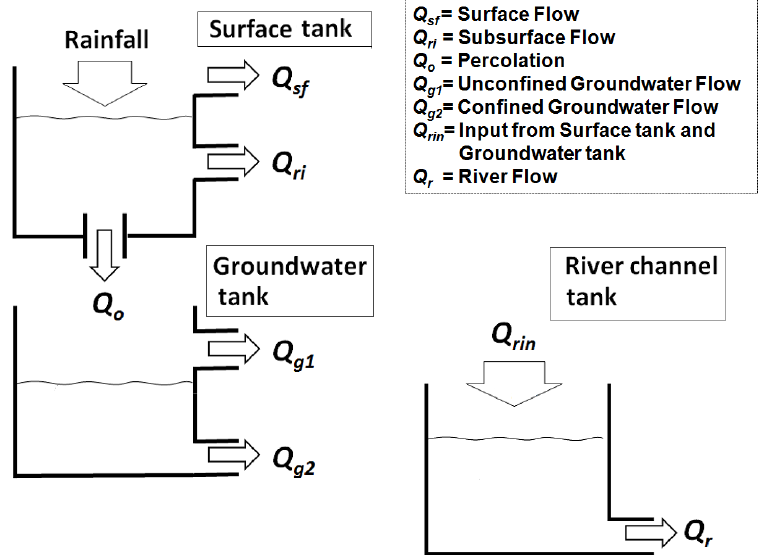
Figure 4. Schematic diagram of the tank models in the Public Works Research Institute (PWRI)-distributed hydrological model. Note that the flows Q become Q rin